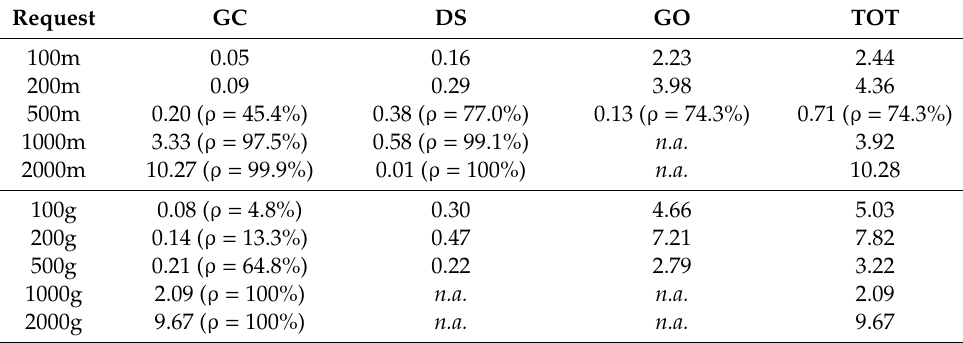
Figure 6. Service response time for the getObservation (a) and describeSensor (b) SOS requests in test